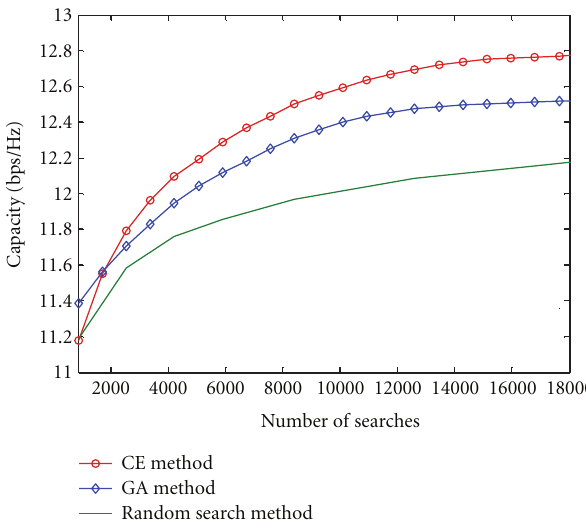
Figure 2: Capacity versus the number of searches for di ff erent methods at SNR =